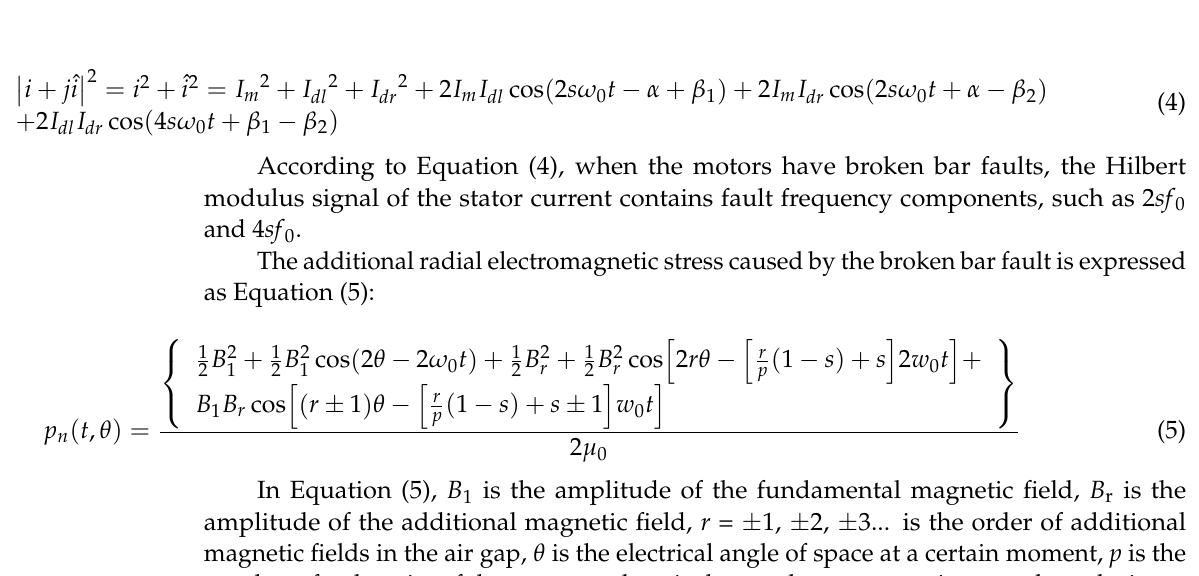
( b ) Figure 3. The spectrum comparison of current signal. ( a ) Normal motor; ( b ) faulty motor with bro- ken rotor bars. 0 ( b ) Figure 4. The spectrum comparison of radial electromagnetic force signal. ( a ) Normal motor; ( b ) faulty motor with broken rotor bars. After using the fusion correlation spectrum to diagnose the fault of the submersible motor and obtain the fault samples, the current signal and the radial electromagnetic force signal of the normal and various faulty motors were further analyzed by the wavelet packet, and the time domain sampling signal can be divided into different frequency bands. The wavelet packet coefficients of different frequency bands and the correspond- ing node energy were respectively calculated, and the signal frequency bands with abnor- mal energy were extracted from them, which were used to construct the feature vector of